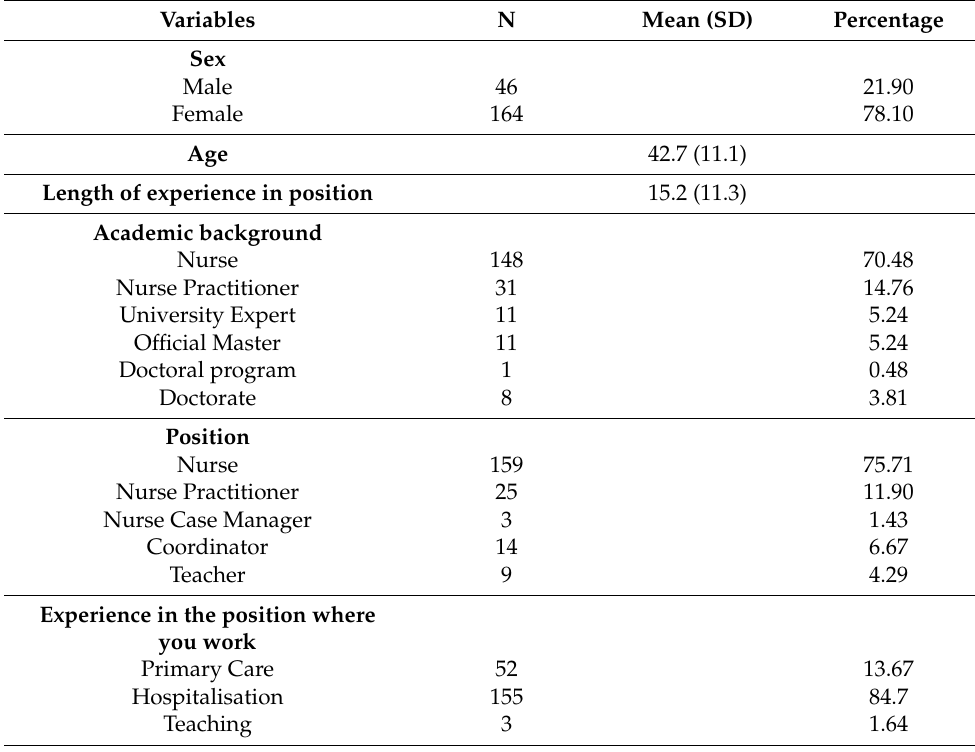
Table 1. Sociodemographic characteristics of the